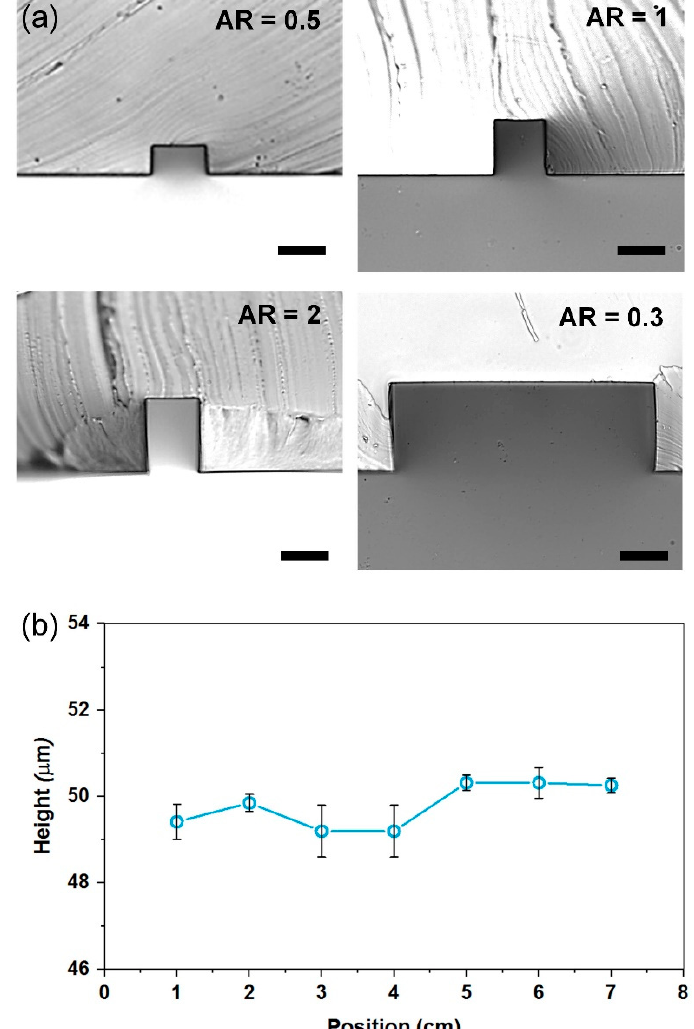
Figure 3. PDMS replicas of ADEX masters. ( a ) Channel cross-sections of various aspect ratios. Scale bar is 20 µm; and ( b ) the average channel height measured along the entire length of the wafer, with coefficient of variation of ~1.1% ( n = 35).